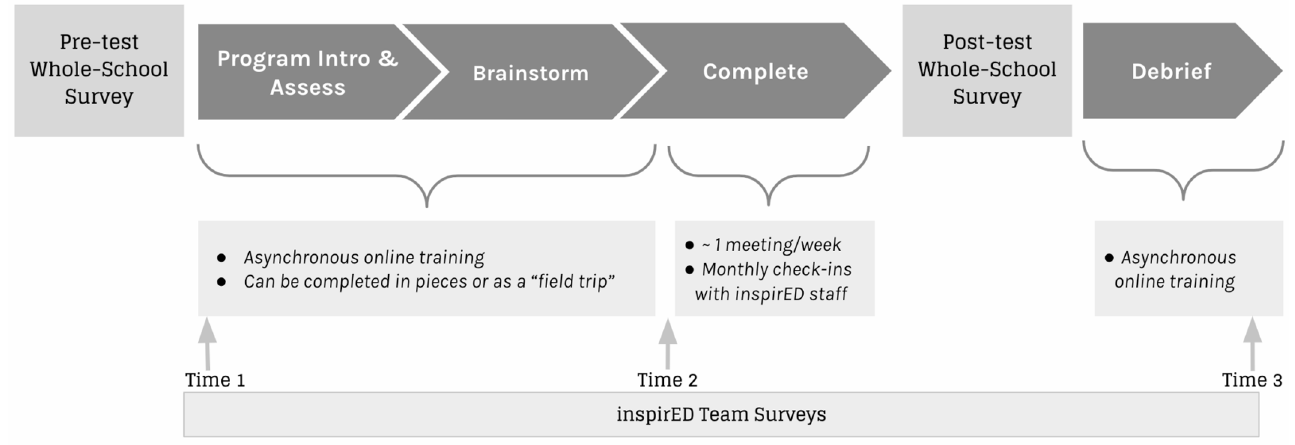
Figure 1. Overview of inspirED Survey and Training Timeline.